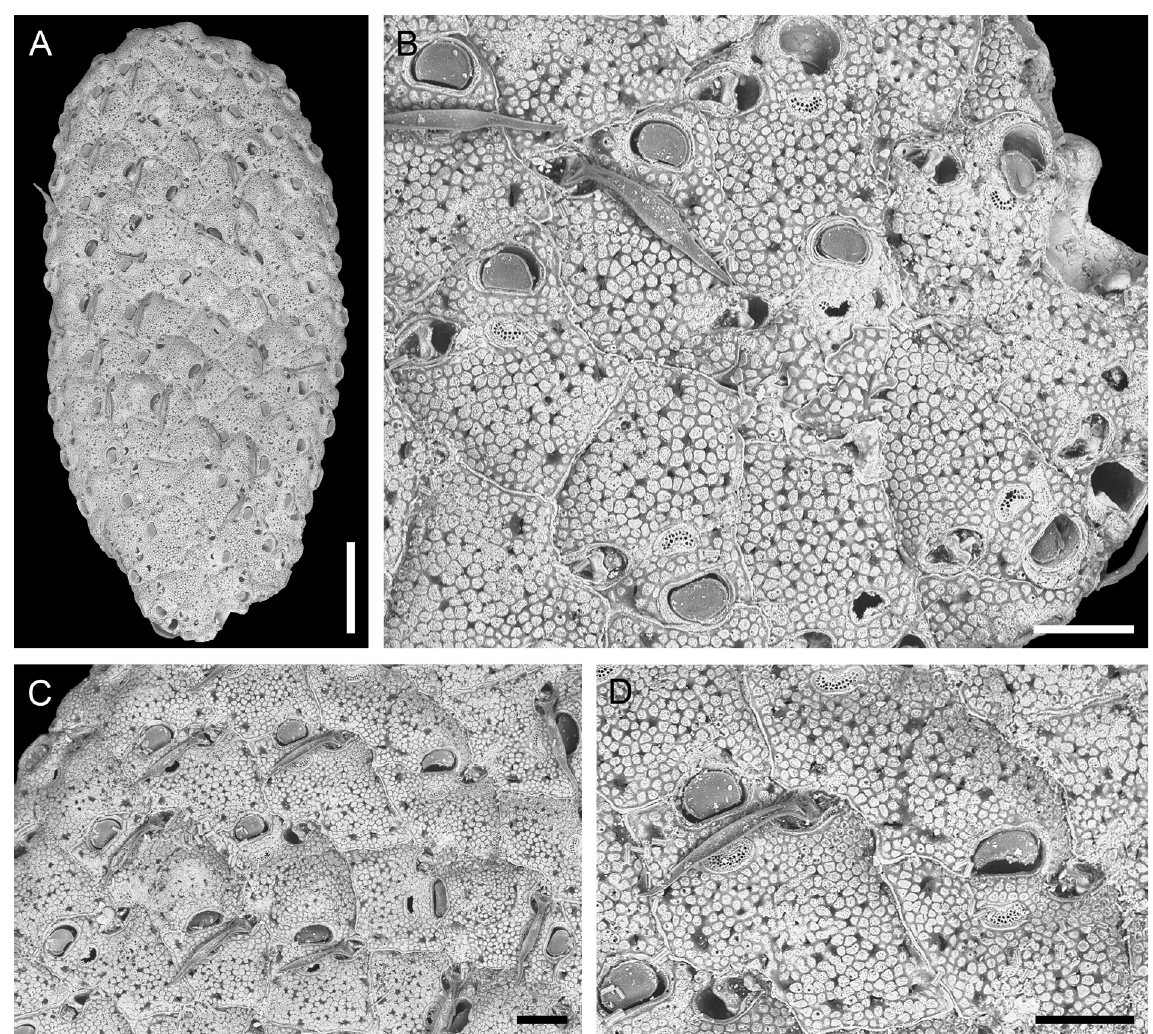
Fig. 9. Microporella lingulata sp. nov., holotype, NIWA 144886 (unbleached), Recent, Foveaux Strait, New Zealand. A . General view of the tongue-shaped colony. B . Apparent ancestrula and periancestrular zooids. C . Group of ovicellate and non-ovicellate zooids. Some avicularia show the long, lanceolate mandibles. D . Close-up of an autozooid, having the avicularian mandible open, and an ovicellate zooid (right). Scale bars: A = 1 mm; B–D = 200